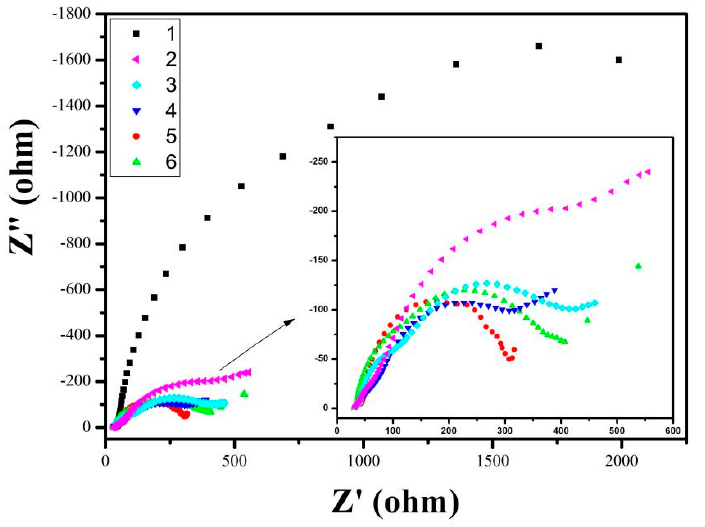
Figure 7. In a 0.1 mol/L Na 2 SO 4 (PH (Hydrogen ion concentration index) = 7) solution, keeping the bias voltage at 1.5 V, using a standard calomel electrode as the reference electrode to test the J-T image of the sample.